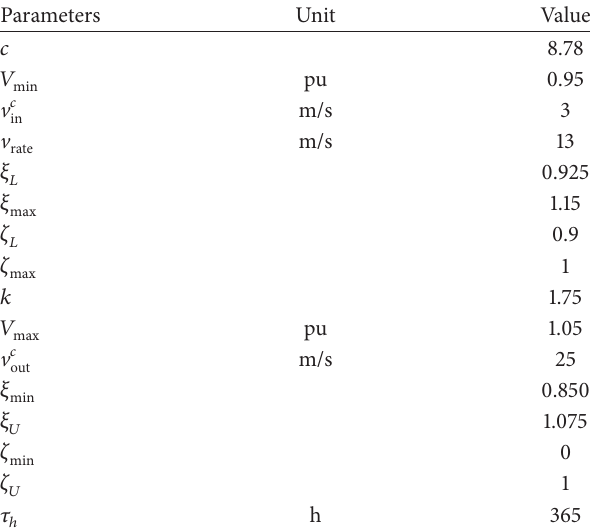
Table 1: Data used in this paper.